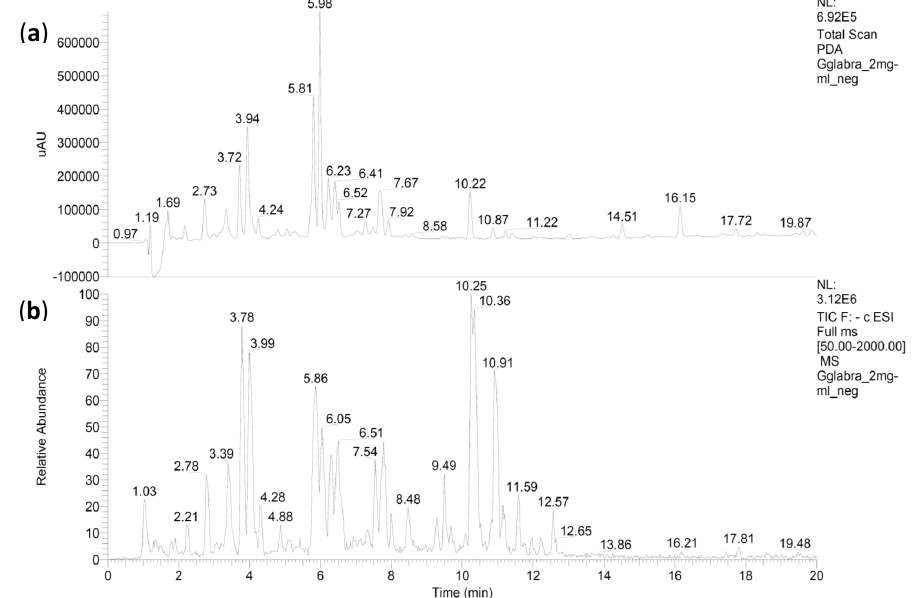
Figure 1. The photodiode array chromatogram (PDA) ( a ) and the total ion current (TIC) ( b ) of the G. glabra extract. The compounds listed in Table 1 correspond to the retention times of the TIC. Table 1. Retention times (RT), MS data, and tentatively identified compounds in the G. glabra extract.